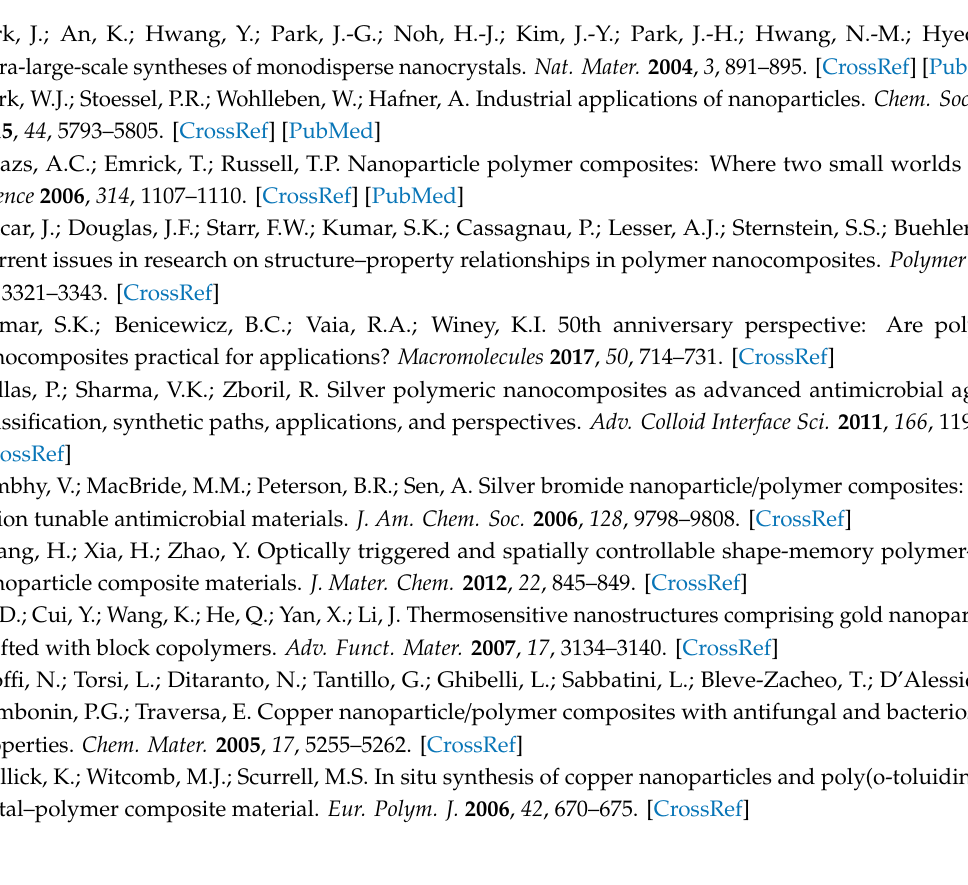
from the top of the polymer melt, Figure S12: UV / Vis absorbance spectra of RITC-SiNPs (d = 25 nm) in water, Figure S13: TEM-images of spherical Rhodamine B isothiocyanate-incorporated silica nanoparticles (RITC-SiNPs) with a diameter of 25 nm, Figure S14: Absorbance profile of gelatin with RITC-SiNPs against radial distance from axis of rotation at di ff erent times after overlaying at λ = 550 nm at 40 ◦ C, Figure S15: Simulated absorbance profile after overlaying of small RITC-SiNPs (d = 25 nm) over time. Radial distance is distance from the top of the polymer melt, Figure S16: Absorbance residuals between simulation and experimental detection for nanoparticle gradient material with RITC-SiNPs (d = 25 nm) before and after solidification at λ = 550 nm. Radial distance is distance from the top of the polymer melt, Figure S17: TEM-Images of spherical superparamagnetic iron oxide nanoparticles (SPIONs) with a diameter of 19